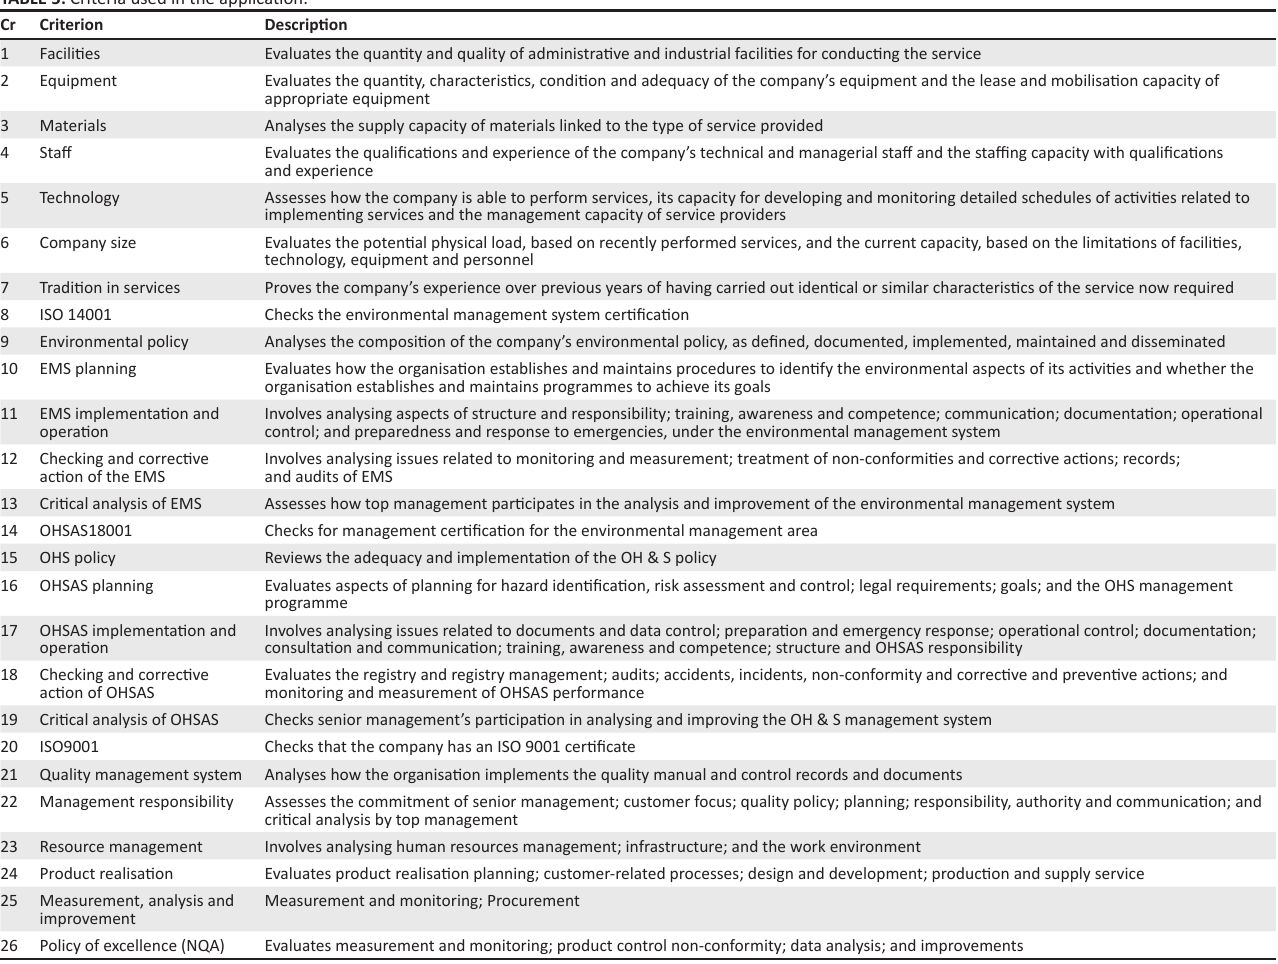
TABLE 5: Criteria used in the application.